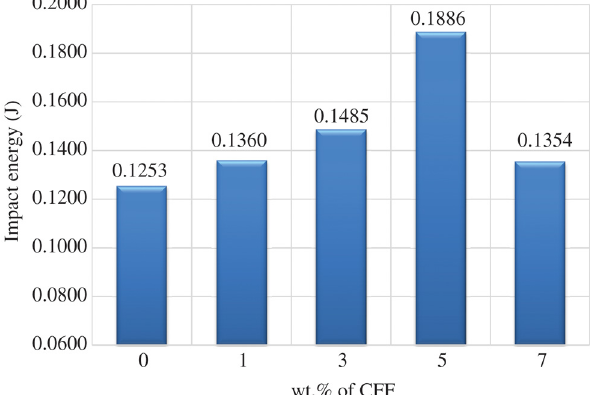
Figure 14: Impact energy for various compositions of CFF